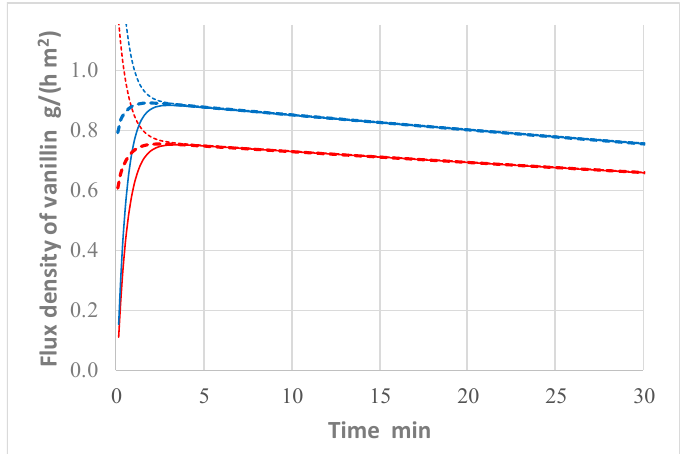
Figure 6. The fitting of the experimental data (dots) by the mathematical model (lines) for some experimental runs at different initial vanillin concentration in Liquid 1. Upstream data (green) and downstream data (red). Upstream initial concentrations: ≈ 6 mM ( a ); ≈ 1.6 mM ( b ); ≈ 0.8 mM ( c ); and ≈ 0.3 mM ( d ). Flow rates for Liquid 1 are indicated in the figure. Flow rates for Liquid 2 = 75 L/h ( a – d ).